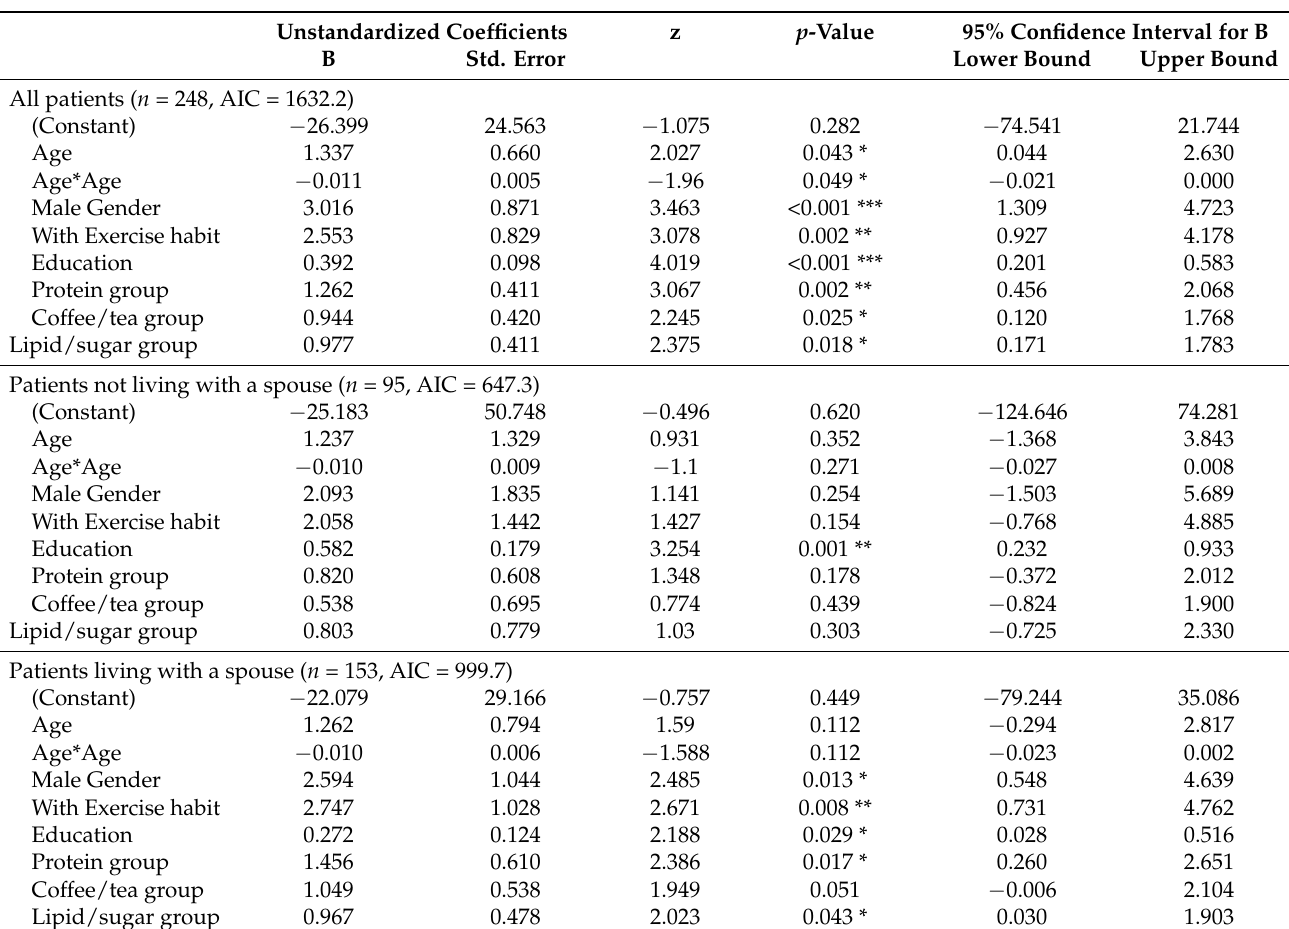
Table 5. The LASSO regression analysis of demographic variables, three dietary patterns (DPs) and MMSE